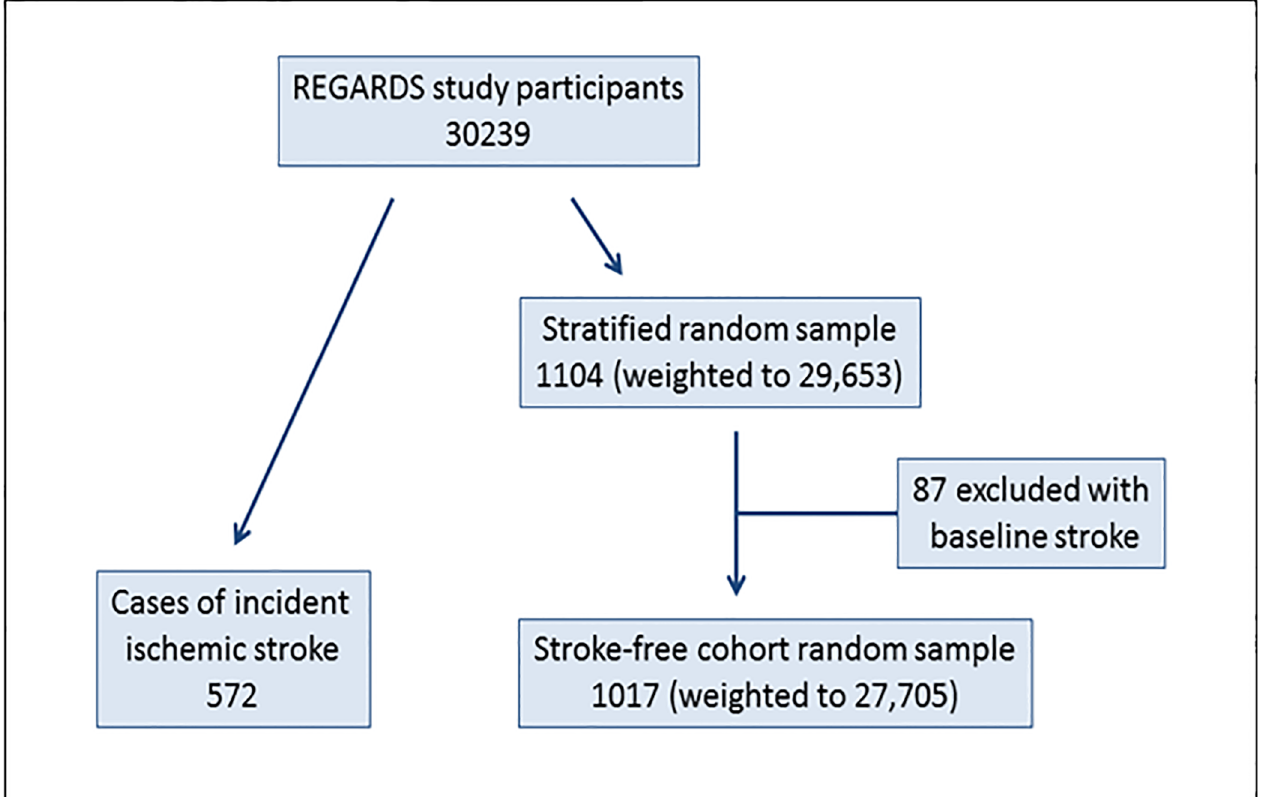
Fig 1. Case-cohort study